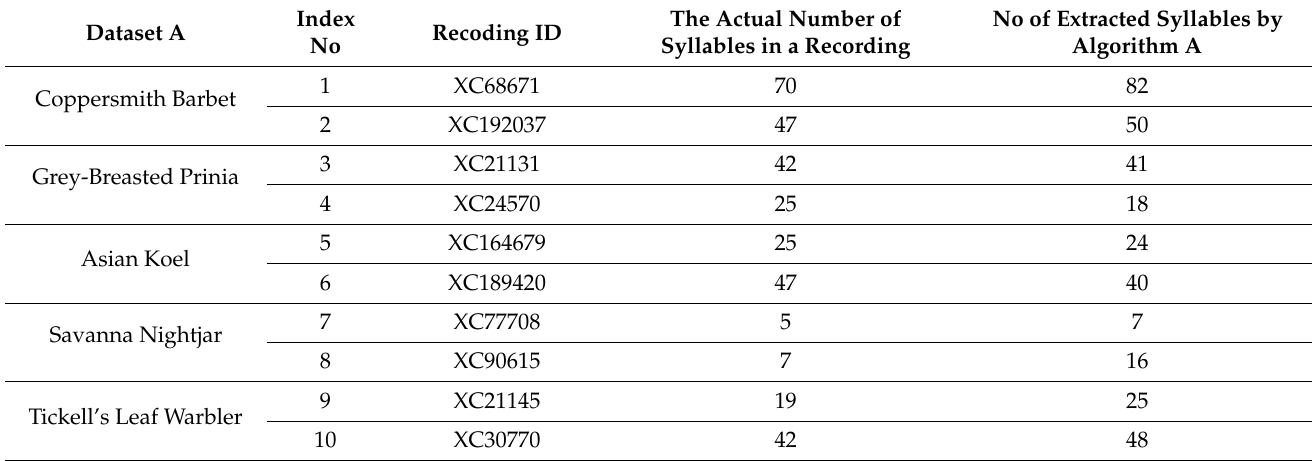
Table 2. Comparison of segmentation results for the single syllable extraction of Monosyllabic Birds.